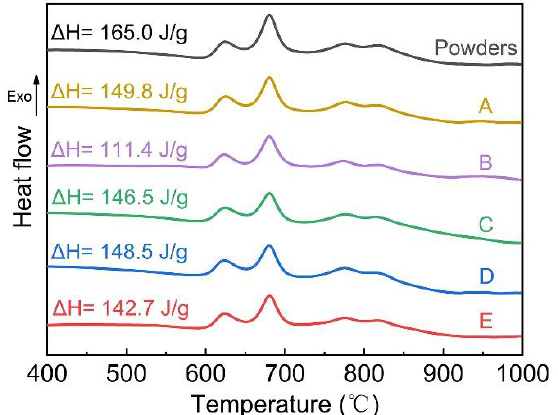
Figure 3. DSC curves of Fe-based amorphous powders and Fe-based AMCs.